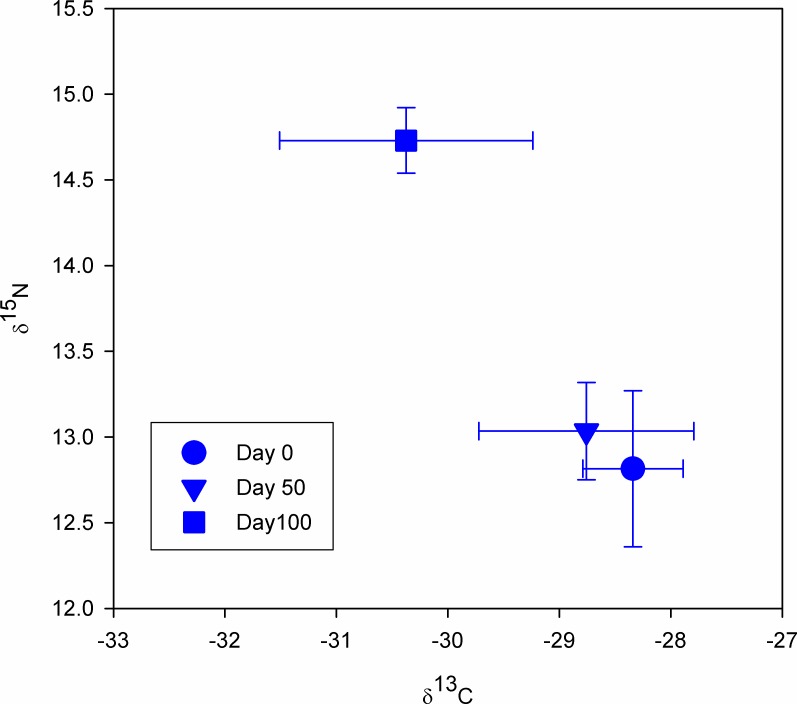
T. nodulosus Nitrogen (δ15N) and carbon (δ13C) values at day 0, day 50 and day 100, respectively.